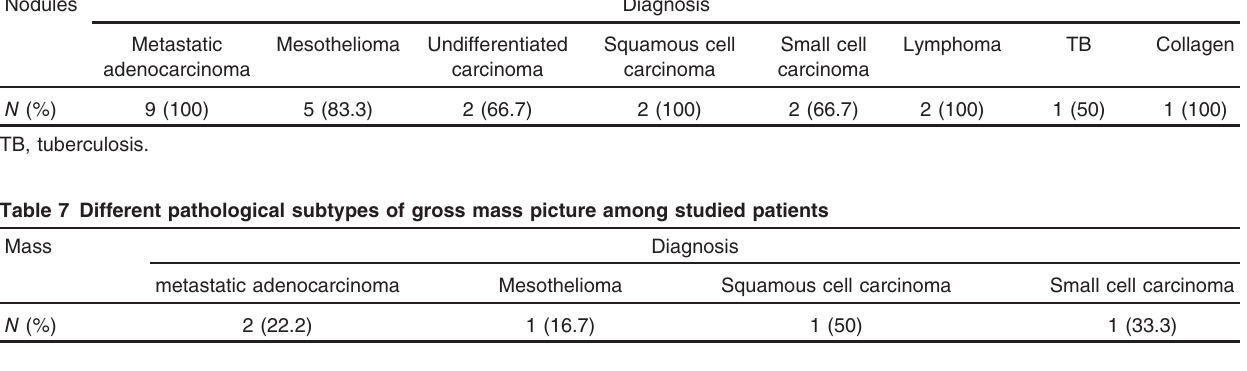
Table 6 Different pathological subtypes of gross nodular picture among studied patients